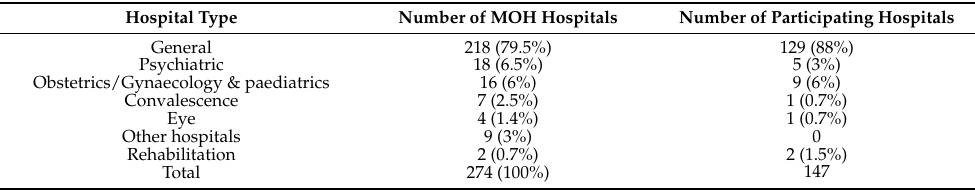
Table 2. Survey responses per hospital type.